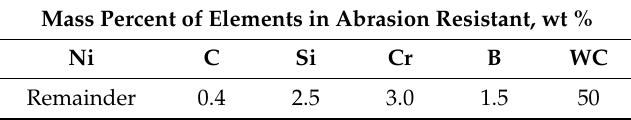
Table 6. Chemical composition and mechanical properties of HARDOX 400.